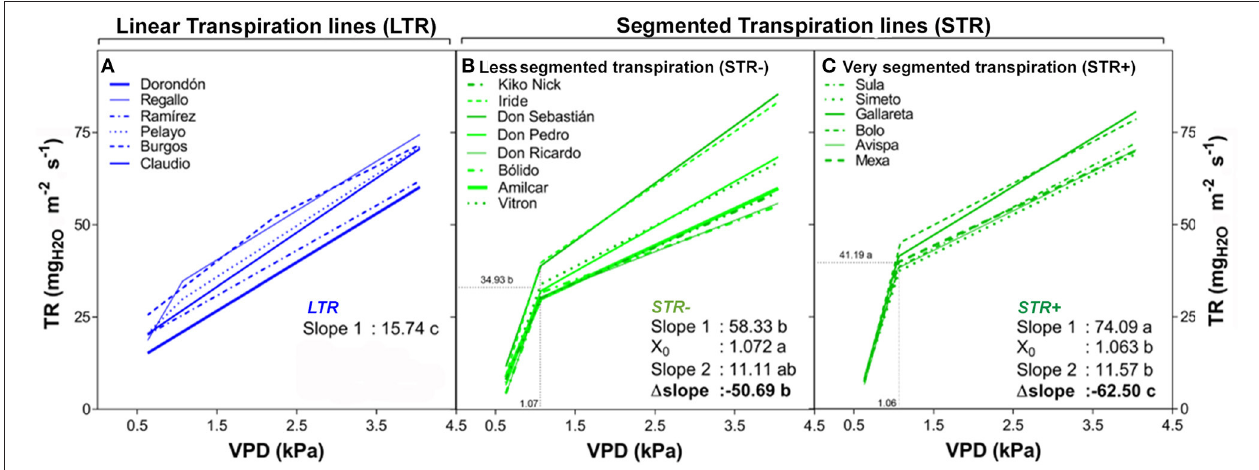
FIGURE 1 | Transpiration rate (TR) of 20 durum wheat lines exposed to increasing VPD regimes as described in Table 3 . Plantlets were growth in pots under well-watered conditions in a greenhouse and the transpiration response was tested in a growth chamber as indicated in the Materials and Methods. Each curve expresses the mean TR values across low to high VPD of a particular line. Plants were tested at the vegetative stage and values represent the mean of five plants (i.e., five biological replicates) per line. (A) The linear regressions of the linear transpiration lines (LTR), and (B,C) the segmented regressions of the segmented transpiration lines [R: less segmented transpiration (STR − ) and very segmented transpiration (STR + )] are shown. All panels show the comparison according to the LSD test ( p < 0.05) indicating the mean slope of the TR response before and after (Slope 1 and 2) putative VPD breakpoints (X 0 ) and their slope variation ( 1